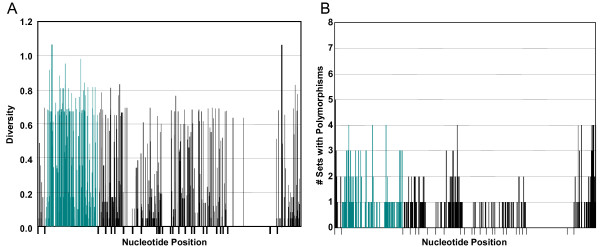
Diversity of nucleotide positions. A. Each bar represents the nucleotide diversity of a single nucleotide position within the alignment of all cloned 185/333 genes. Green bars represent nucleotide positions within the intron. Gaps due to missing elements were excluded from the diversity calculations. B. Hypervariable positions within the 185/333 genes were identified using diversity analysis on clones belonging to cDNA-based sets (Table 5) with more than two members (94 genes total). Because sets had variable numbers of members, which artificially increases diversity for positions in sets with fewer members, each diversity score greater than 0 was assigned a value of 1. Each bar in the graph represents the number of sets (out of 8 total) that contained a polymorphism at the specific nucleotide position. Green bars indicate positions within the intron. Bars below the x-axis denote the borders between elements (cDNA-based alignment).